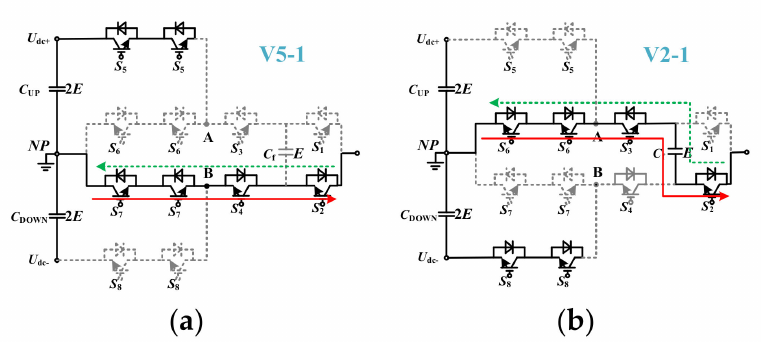
Figure 5. Switching states V5-1 and V2-1 at zero crossing point. ( a ) Switching states V5-1. ( b ) Switch- ing states V2-1.